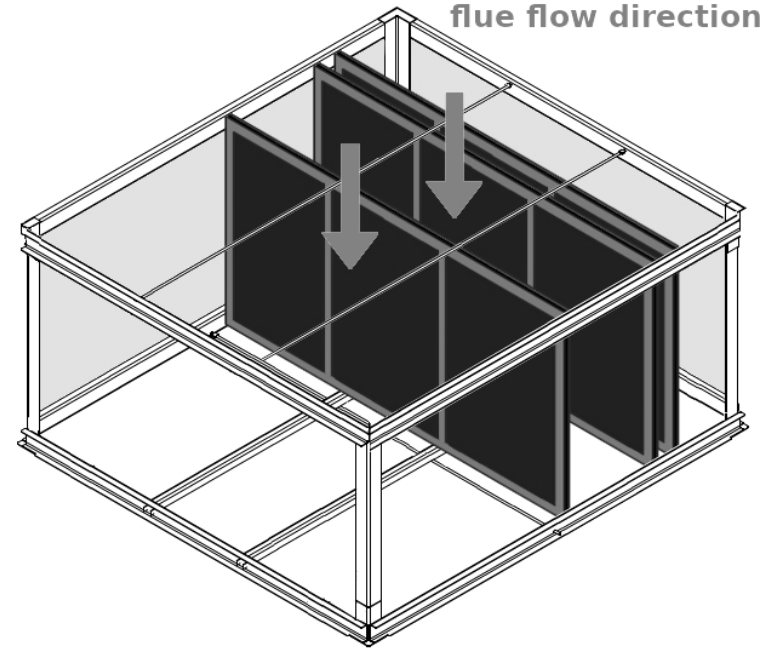
Figure 6. The prototype of the sorption module “V2” for industrial tests.